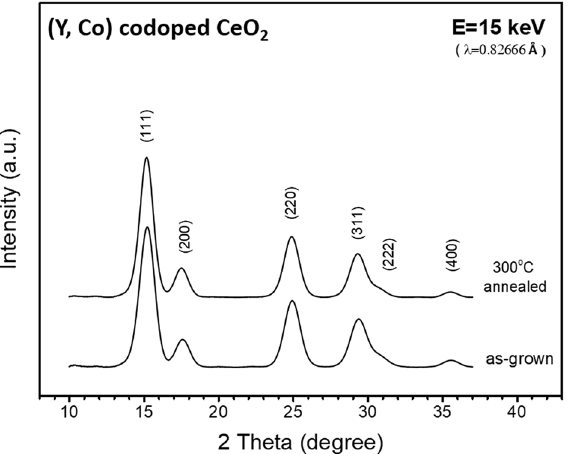
Figure 1. XRD patterns of the as-grown and thermally annealed samples. The X-ray photon energy selected for these measurements is 15